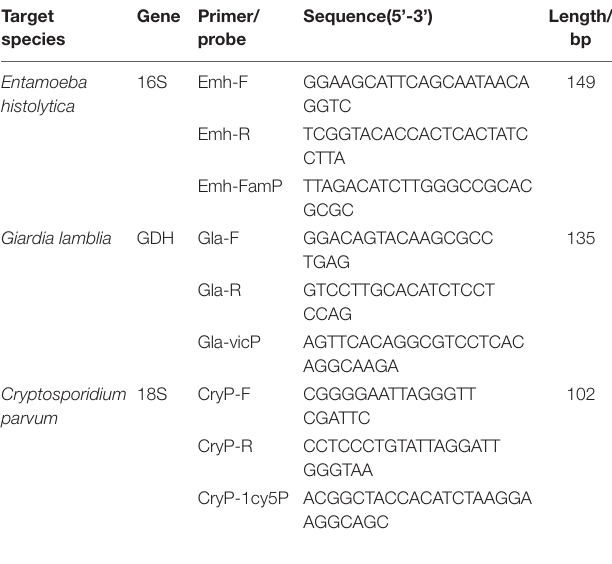
TABLE 1 | Primers and TaqMan probes for quantitative PCR